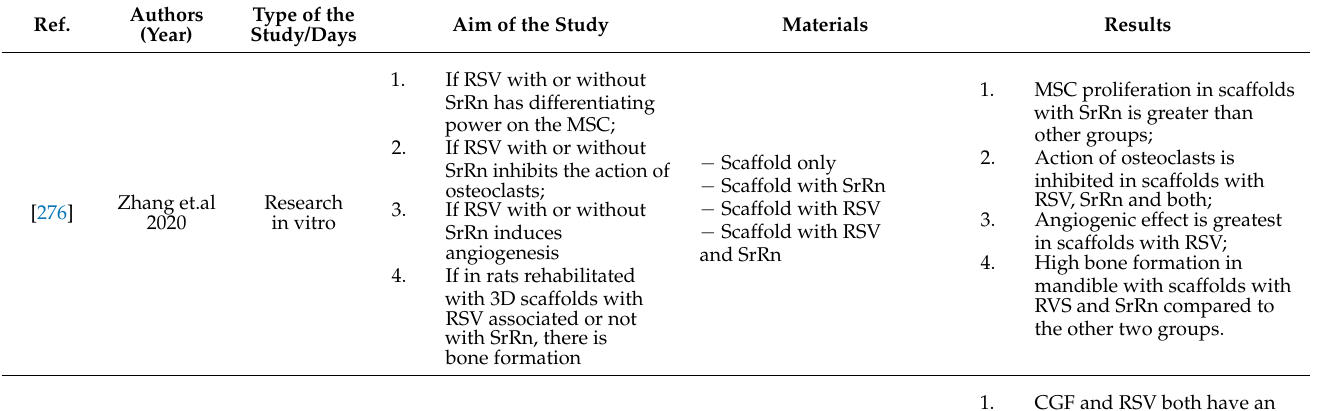
Table 6. Reported RSV results in bone